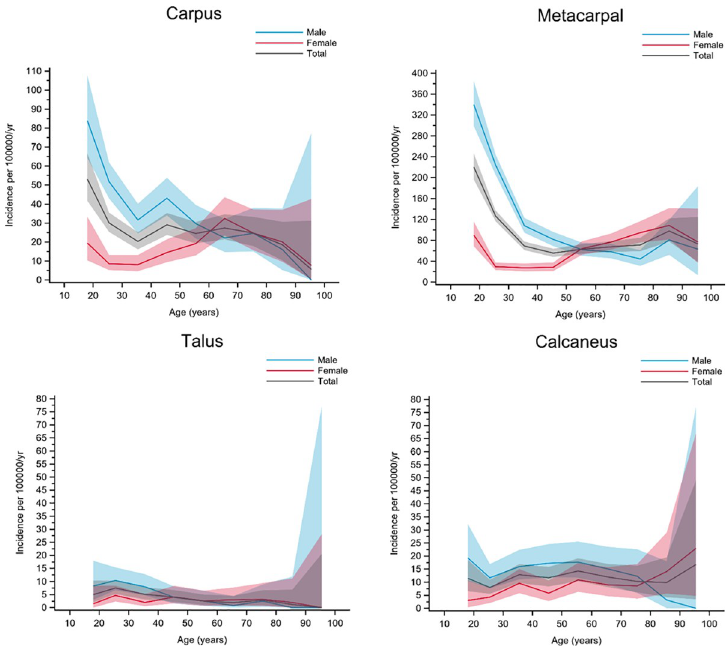
Fig 8. Fractures in group G. Age- and gender-specific incidence with 95% confidence interval. Black line represents the total population; red line represents females and blue line represents males.